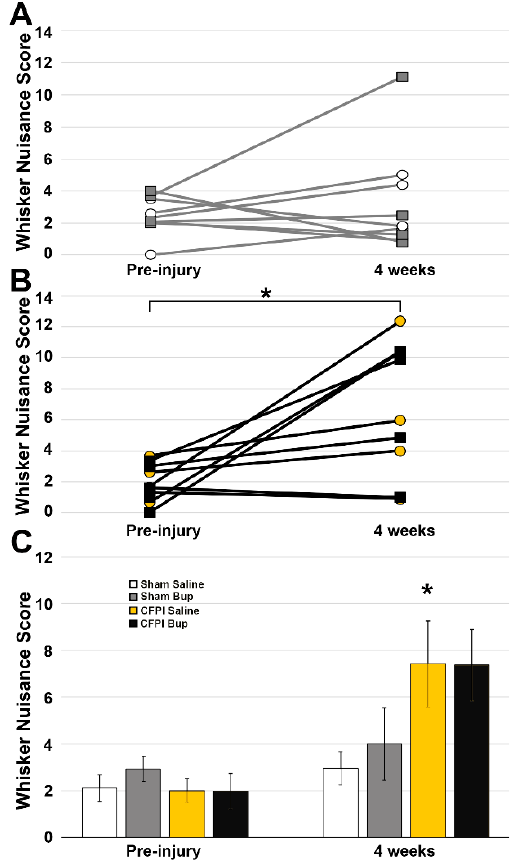
Figure 8. Somatosensory sensitivity was not impacted by Bup-SR-Lab (Bup) treatment. Line graphs of ( A ) sham or ( B ) cFPI animals whisker nuisance scores pre-injury and at 4w post-injury in groups treated with saline (circles; white circles in A are sham saline treated and yellow circles in B are cFPI saline treated animals) or Bup (squares; grey squares in A are sham Bup treated and black squares in B are cFPI Bup treated animals). Each line represents an individual animal. * p < 0.05 compared to pre-injury score. ( C ) Bar graph depicting the mean whisker nuisance task score prior to and 4w following sham or cFPI and saline or Bup treatment. n = 6 rats/group. Mean ± SEM. * p > 0.05 compared to sham saline at 4w.